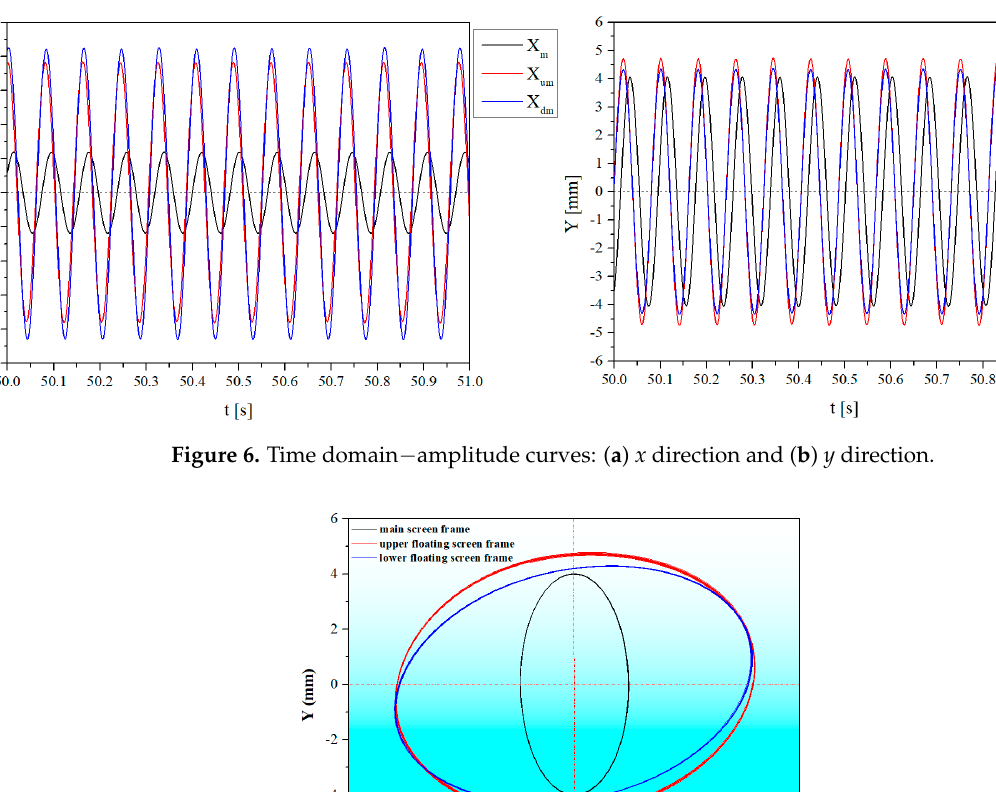
Figure 5. The (a) raw materials and (b) cumulative grain size curves of samples.